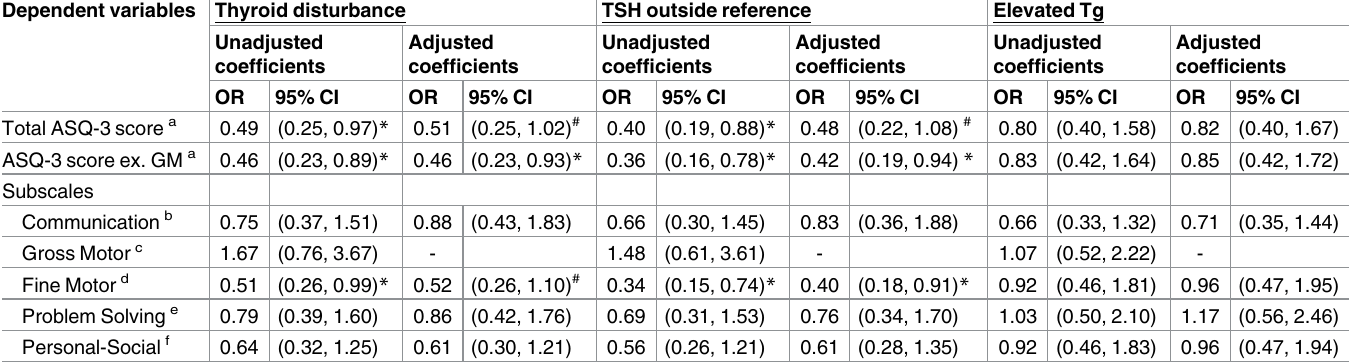
Table 4. Associations between thyroid disturbances, TSH outside referenceand elevated Tg with being in the two upper thirds of the total ASQ-3 score, ASQ-3 score ex. GM and subscales